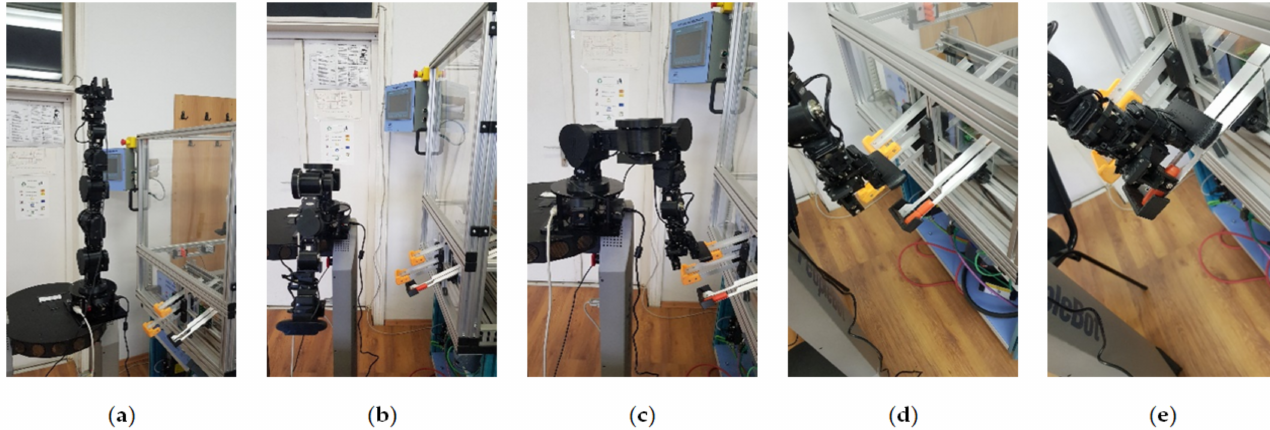
Figure 18. Real-time control of the 7-DOF Cyton 1500 RM located at the FC with the following sequences: ( a ) home position, ( b ) intermediary position, ( c , d ) scanning position, ( e ) picking object.